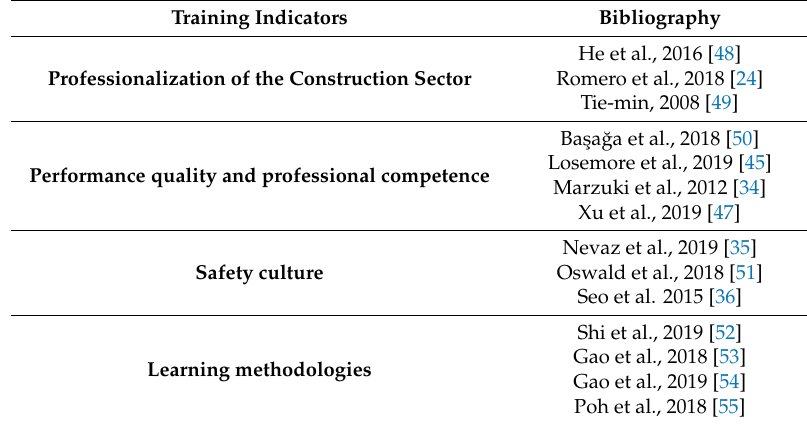
Table 2. Bibliographical references concerning employee training in safety and risk